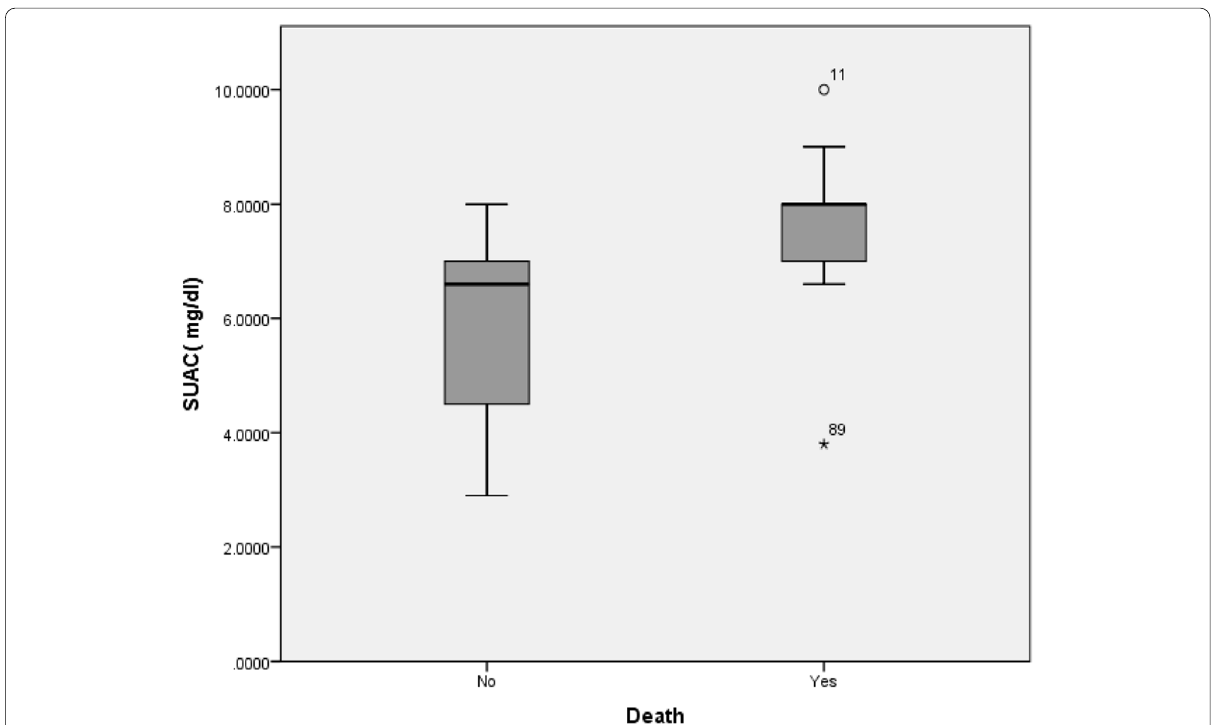
Fig. 2 Association of serum uric acid and death in the study